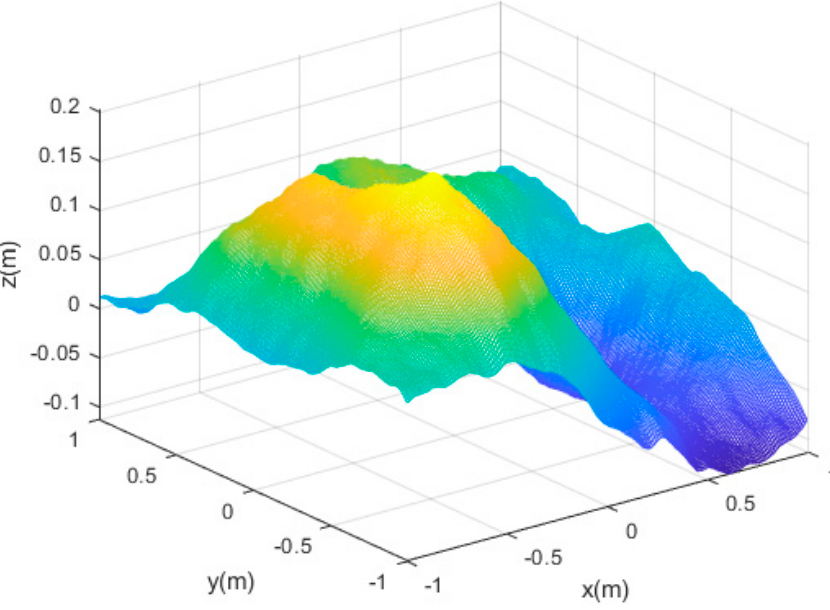
Figure 1. Ocean surface simulation (superposed WSAWs). Wind speed: 3